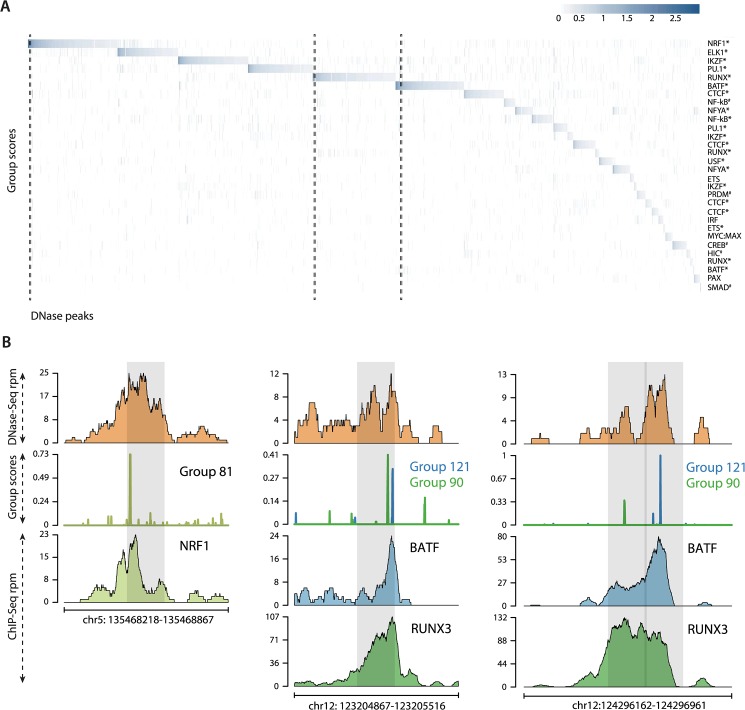
Sequence preferences of GM12878 DNase-seq peaks.(A) Heatmap showing the group scores for top groups over 16,891 GM12878 DNase-seq peaks. Note that some peaks have a sequence signal for a single factor while others have signals for multiple factors (FDR-corrected p < 0.01). All the group predictions identified by “*” have been validated by ChIP-seq data, while “#” indicates no ChIP-seq data available in ENCODE. The dashed boxes highlight the specific examples illustrated in Fig 5B. (B) The left panel shows a DNase peak with a strong score for a single transcription factor (NRF1). The middle panel shows DNase peaks with moderate scores for both BATF and RUNX. The left panel shows different binding preferences in adjacent split peaks derived from a single broad peak. All the predictions are validated by ChIP-seq.